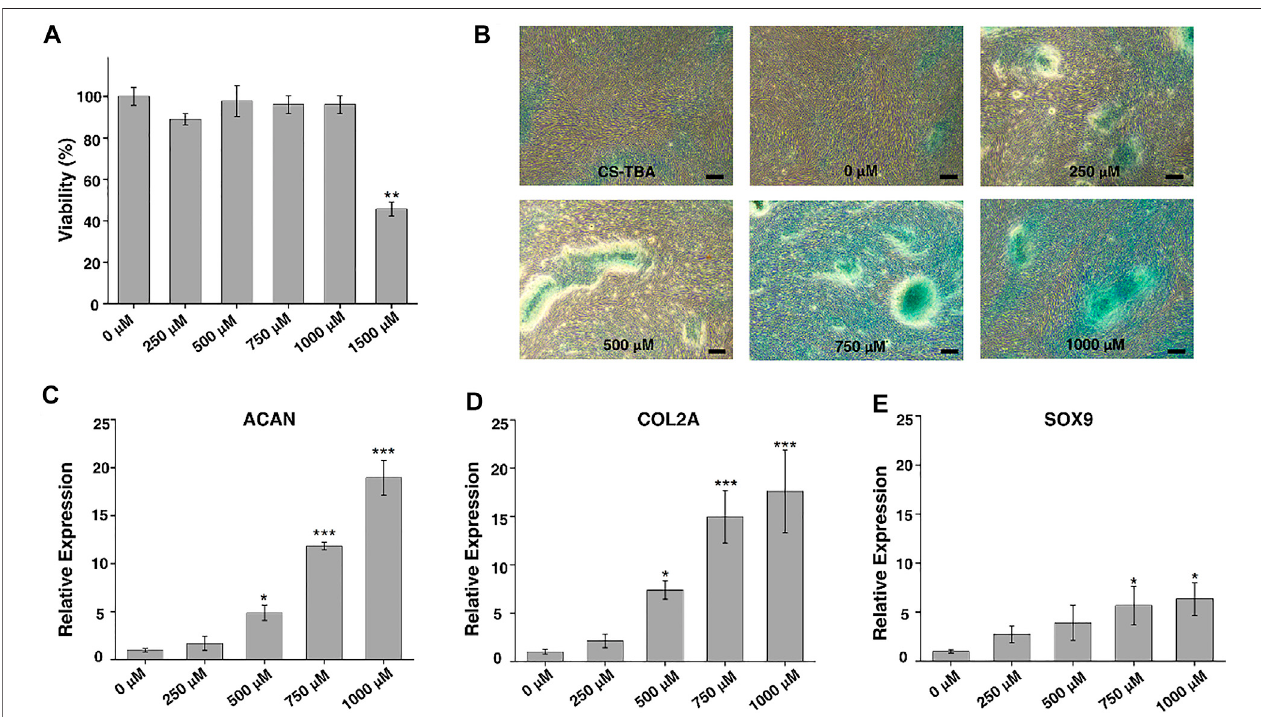
FIGURE 2 | (A) CCK-8 assay of ADSCs cultured with cell culture medium containing different amounts of KGN. (B) AB staining of ADSCs after chondrogenic differentiation for 21 days induced by CS-TBA and different concentrations of KGN (scale bar: 20 μ m). (C – E) The expression levels of chondrogenesis-related genes such as ACAN (C) , COL2A (D) , and SOX9 (E) after chondrogenic differentiation induced by different concentrations of KGN. The statistic comparison was made betweenacontrolgroup (0 μ M)and eachKGN group(250 μ M,500 μ M,750 μ M,and 1,000 μ M). p valueof < 0.05wasconsidered signi fi cant.* p < 0.05and *** p <